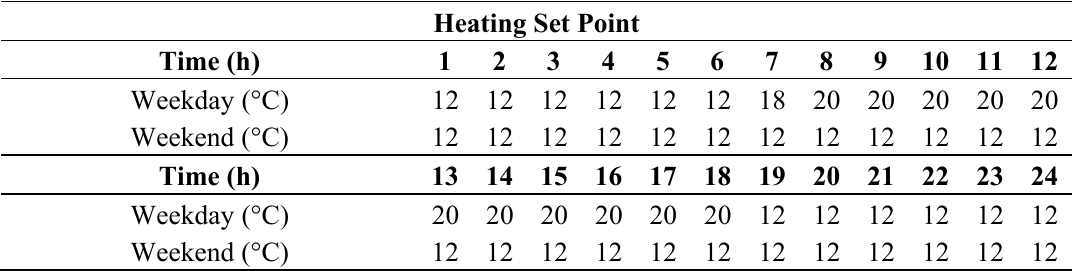
Table A5. Schedules for the GB 50189–2005 code-compliant building